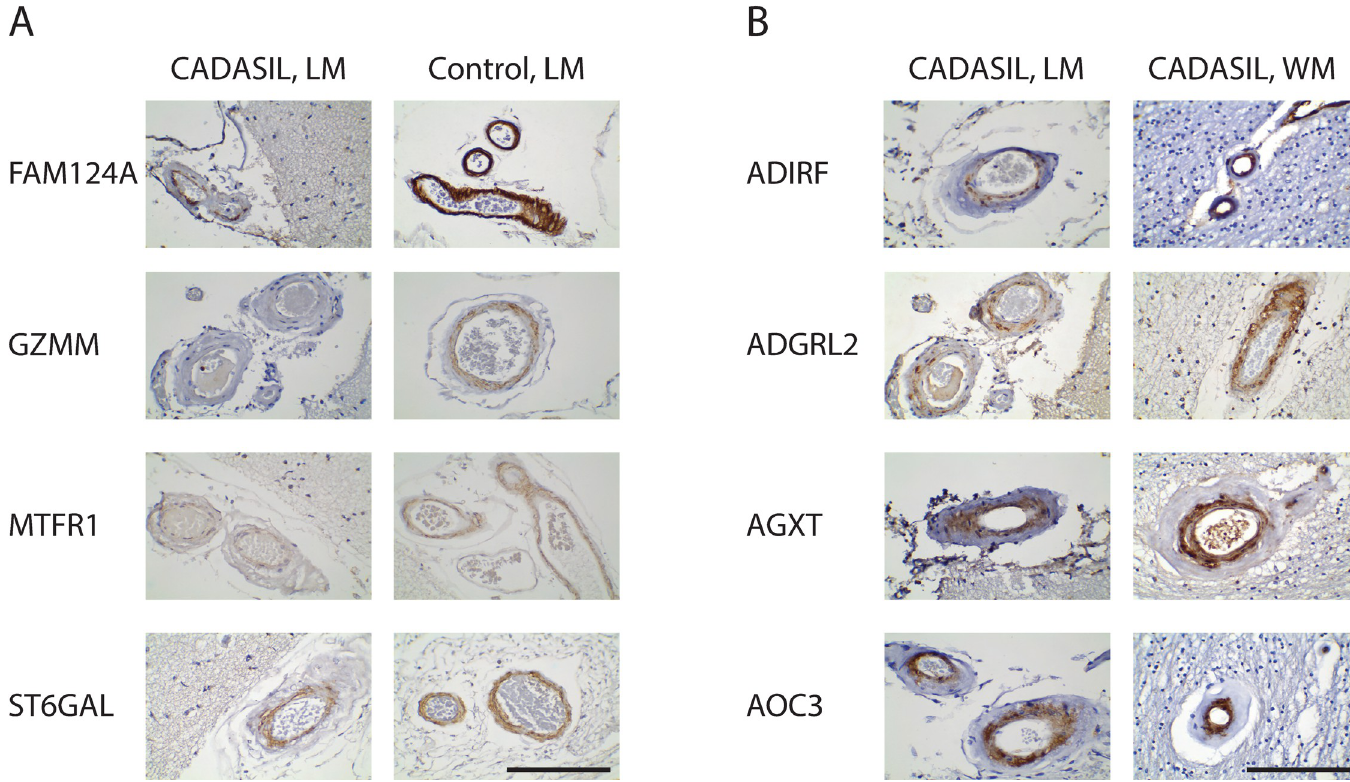
Fig 4. Markers exhibiting differential levels of staining between CADASIL and control arteries or between leptomeninges and white matter. Images from Figs 2 and 3 are placed side by side for easier comparison. A) Immunohistochemical examination of markers (labels to the left) which had decreased staining in CADASIL relative to controls. Representative leptomeningeal arteries (LM) are shown. B) Immunohistochemical comparison of markers (labeled on the left) in leptomeningeal arteries and white matter arteries (WM) in representative CADASIL brain samples. A select group of markers showed moderate white matter enrichment pattern in CADASIL vessels. Scale bar shows 100